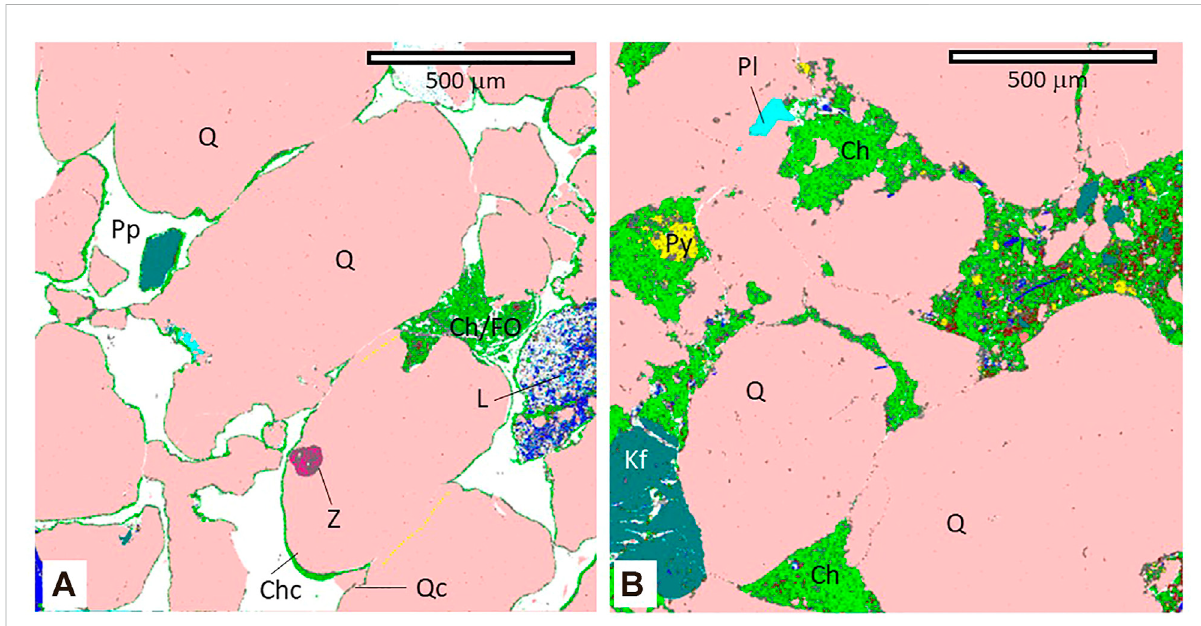
FIGURE 13 Types of chlorite in quartz-dominated Lower Jurassic deltaic sandstones from Halten Terrace, Norway, with minor feldspars (mineral colour index in Figure 3). (A) Well-developed chlorite coats (Chc) occur on most exposed sand-grain surfaces including quartz (Q) and lithics (L) but quartz cement (Qc) has managed to start growing at a small number of sites. An inclusion of zircon is present within one quartz grain. Quartz-quartz grain boundaries (yellow dashed lines) are chlorite-free suggesting that at least some of the chlorite grain coat developed after some degree of compaction.Abundant primary porosity (Pp)remains andthere is secondary porosity associated with partly replaced lithic grains (B) Extensive pore- fi lling chlorite that has probably inhibited quartz cement growth, but it has also occluded the pores resulting in low porosity. Pyrite (Py) is present within some patches of chlorite suggesting that seawater sulphate, converted into sulphide,has competed for some ofthe available iron and limited chlorite (or Fe-precursor clay)